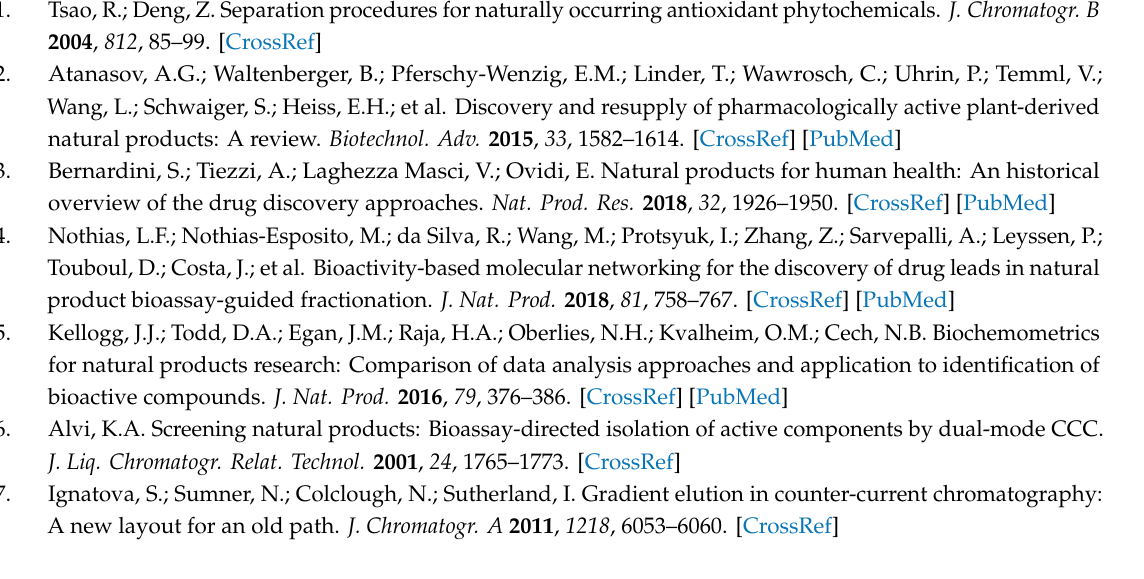
Figure S1: Preparation of simulating solvent systems for the gradient elution, Figure S2: CME ARE-luciferase induction activity, Figure S3: CME and marker compound HPLC chromatograms. Table S1: Volume ratio and settling time of biphasic solvent systems, Table S2: The solvent composition in a simulating solvent system of n -hexane–acetonitrile–water, ethyl acetate–acetonitrile–water, and water-saturated n -butanol–acetonitrile–water (10:2:8, v / v / v